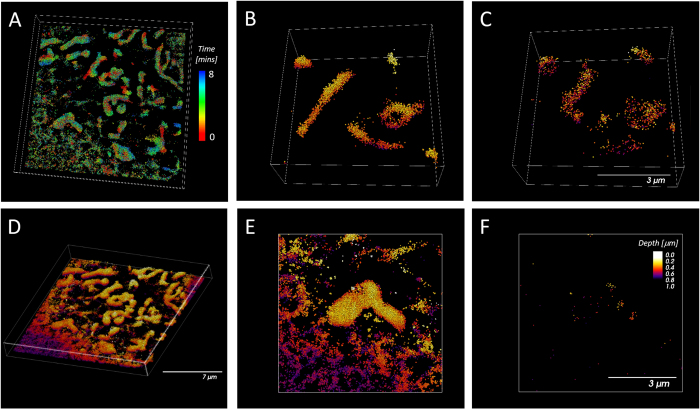
3D Live Cell Super-resolution Imaging of Mitochondria with MitoRed AIE Probe over 8 mins.(A) All detected localizations within 8 mins of imaging, color-coded for time. (B) Detected localizations in the first 10 sec of observation. (C) Detected localizations in the last 10 sec of observation. (D) 3D image of the same time series (all time points combined) color-coded for localization z-depth. (E) Magnified view of a single mitochondrion (all time points combined) color-coded for localization z-depth. (F) Magnified view of a single mitochondrion (localizations detected in 1 sec) showing intra-mitochondrial structure color-coded for localization z-depth.